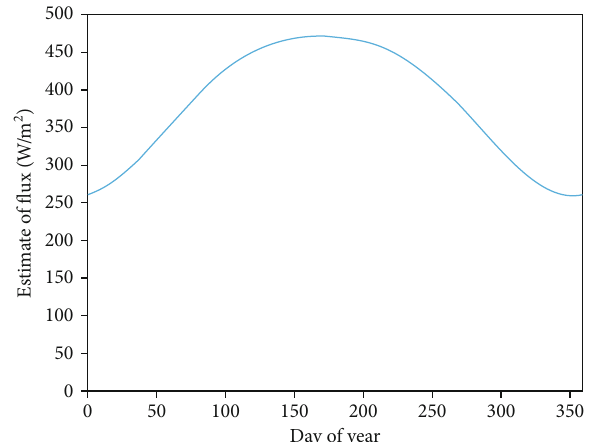
Figure 11: Estimate of radiative fl uxes in Monterrey, Nuevo Leon,